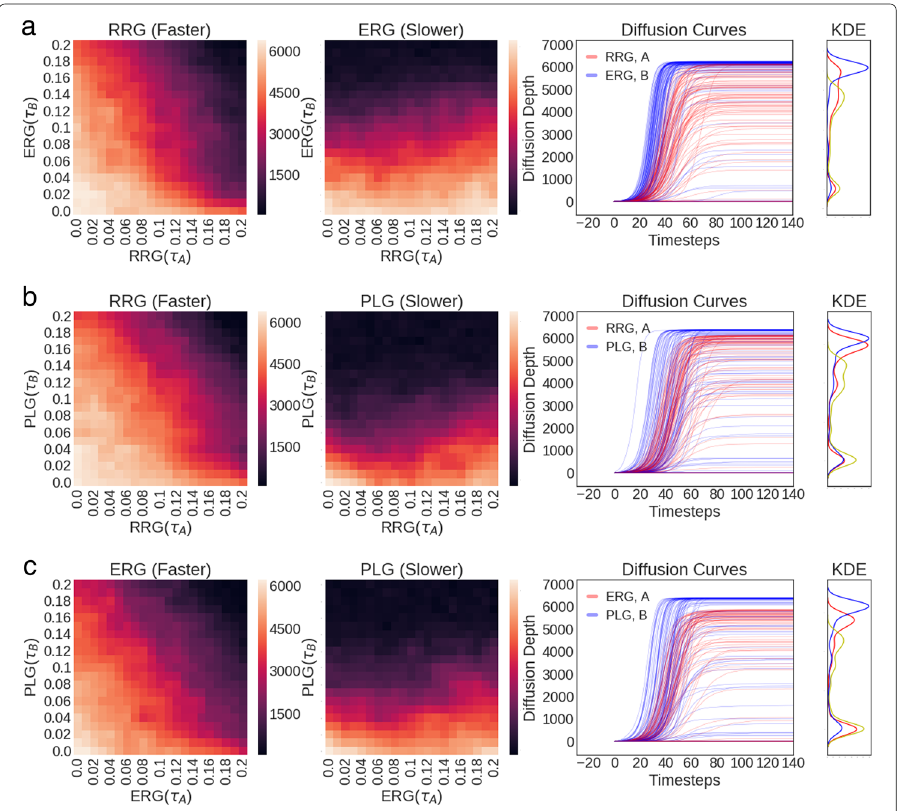
Fig.7 Heat-maps of diffusion depth by network pairings and bi-modal diffusion curve examples. Each row is a network pairing, with ( a ) RRG-ERG, ( b ) RRG-PLG, and ( c ) ERG-PLG. The first column shows the faster contagion (all things equal), and second the slower contagion. The faster contagion’s diffusion depth depends on both dormancy rates, shown by the diagonal, whereas the slower contagion depends more on its own